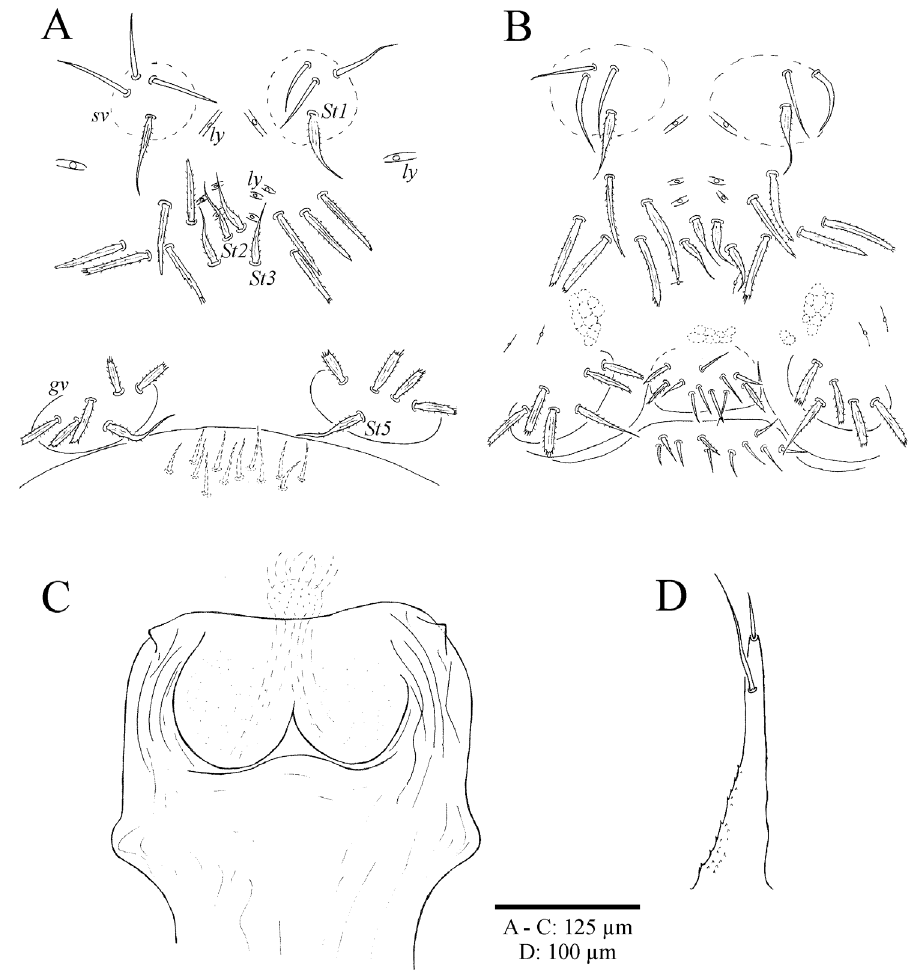
Figure 5. Neocarus spelaion sp. n.: A View of female sternitogenital region B View of male sternitogenital region C View of invaginated ovipositor D Sternapophyses. Abbreviations; sv = sternal verrucae, gv = genital verrucae, st1 – 5 = sternitogenital setae, ly =